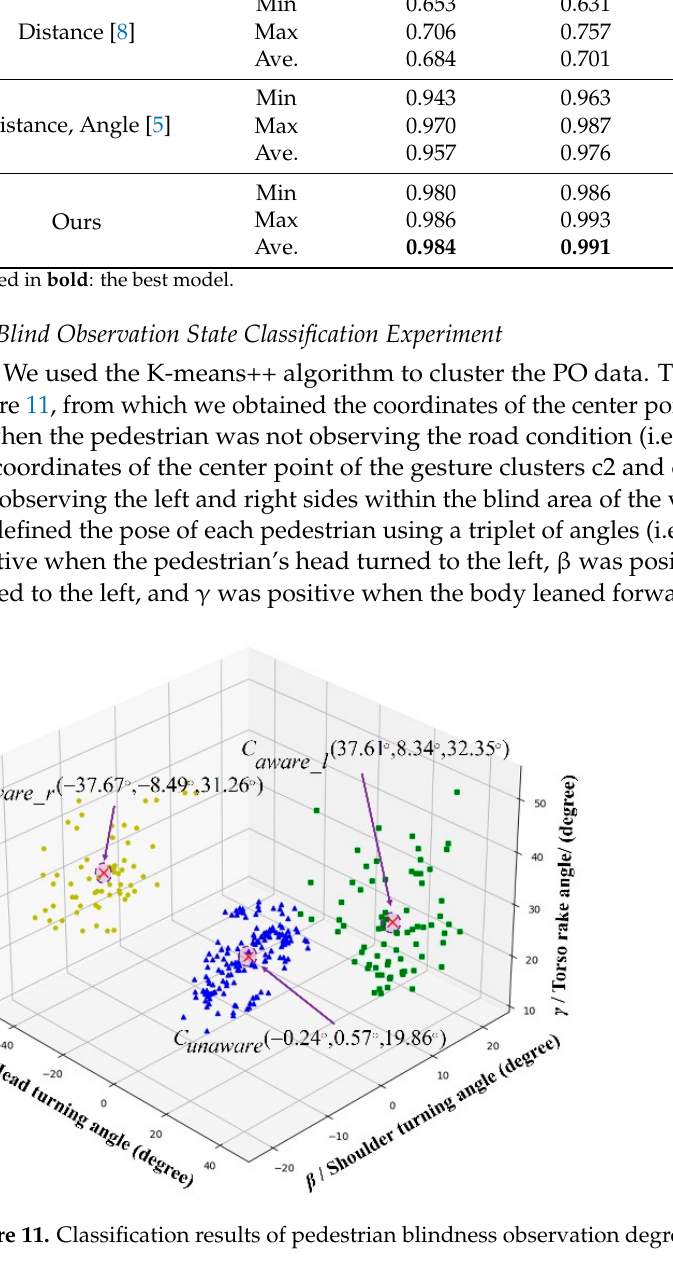
Figure 12. Schematic diagram of pedestrian blind spot observation status classification. N.O. de- notes “No Observation”, meaning the pedestrian did not observe the traffic condition in the blind